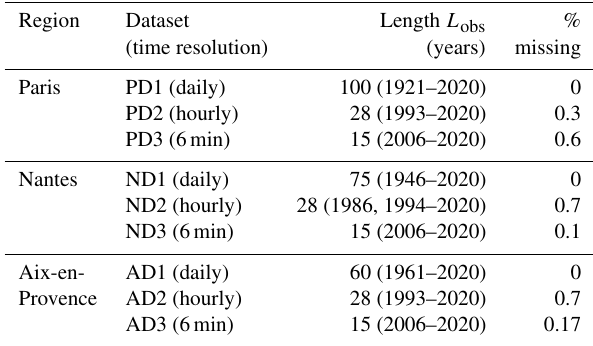
Table 3. Temporal resolution, length and percentage of missing data of rainfall datasets used in this